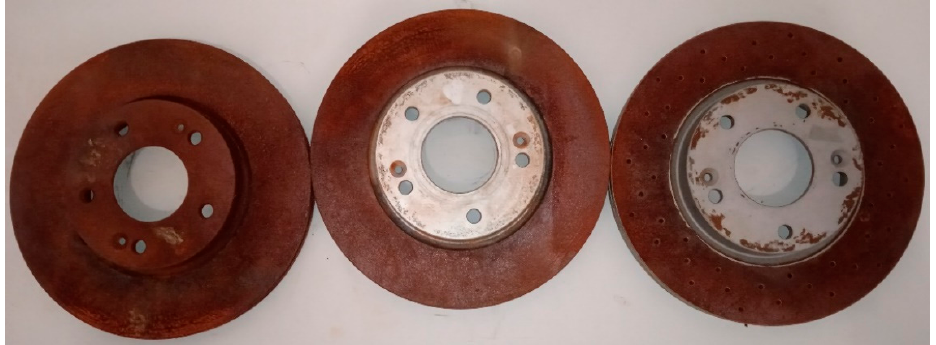
Figure 17. Corrosion on the outer side of brake discs .